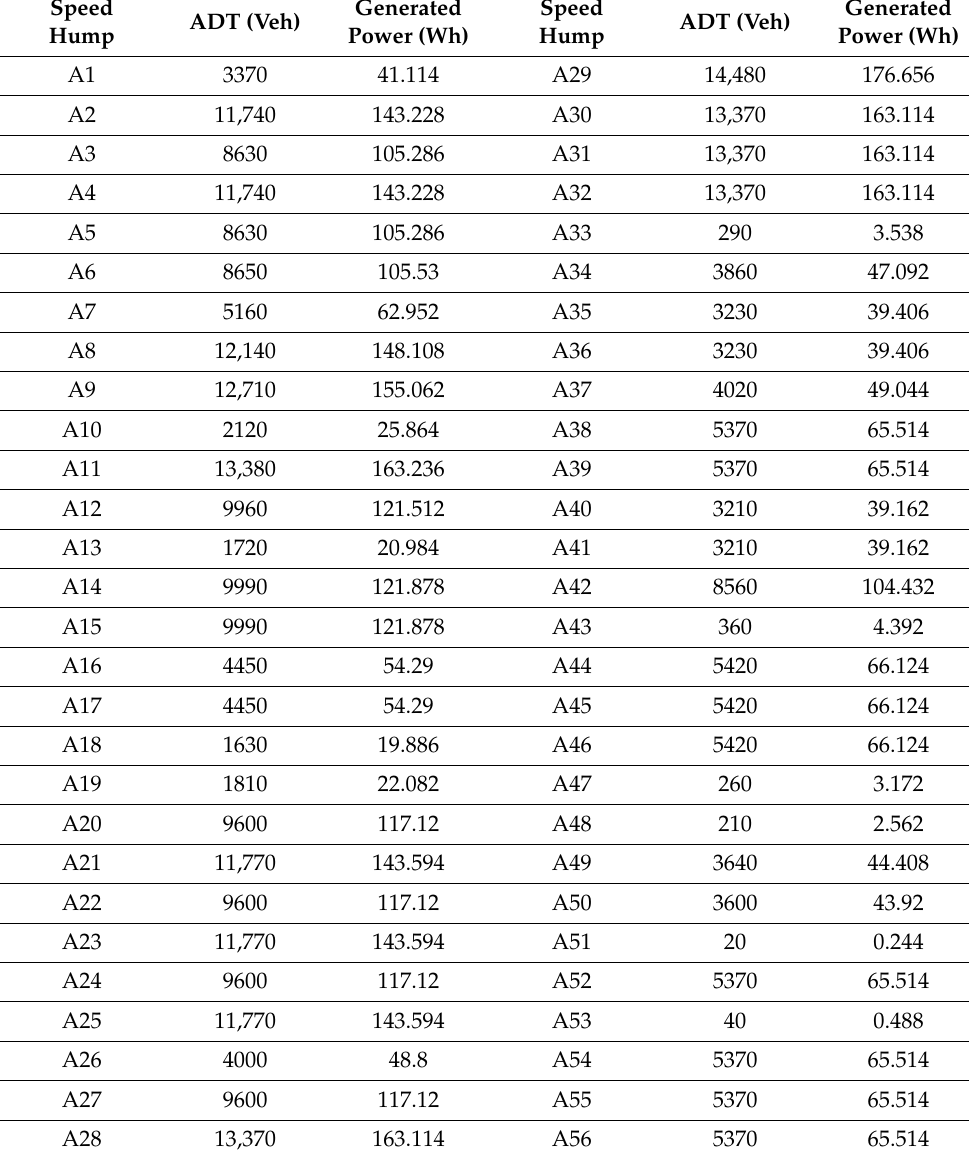
Table 5. Average amount of power generated each day by each speed hump in zone